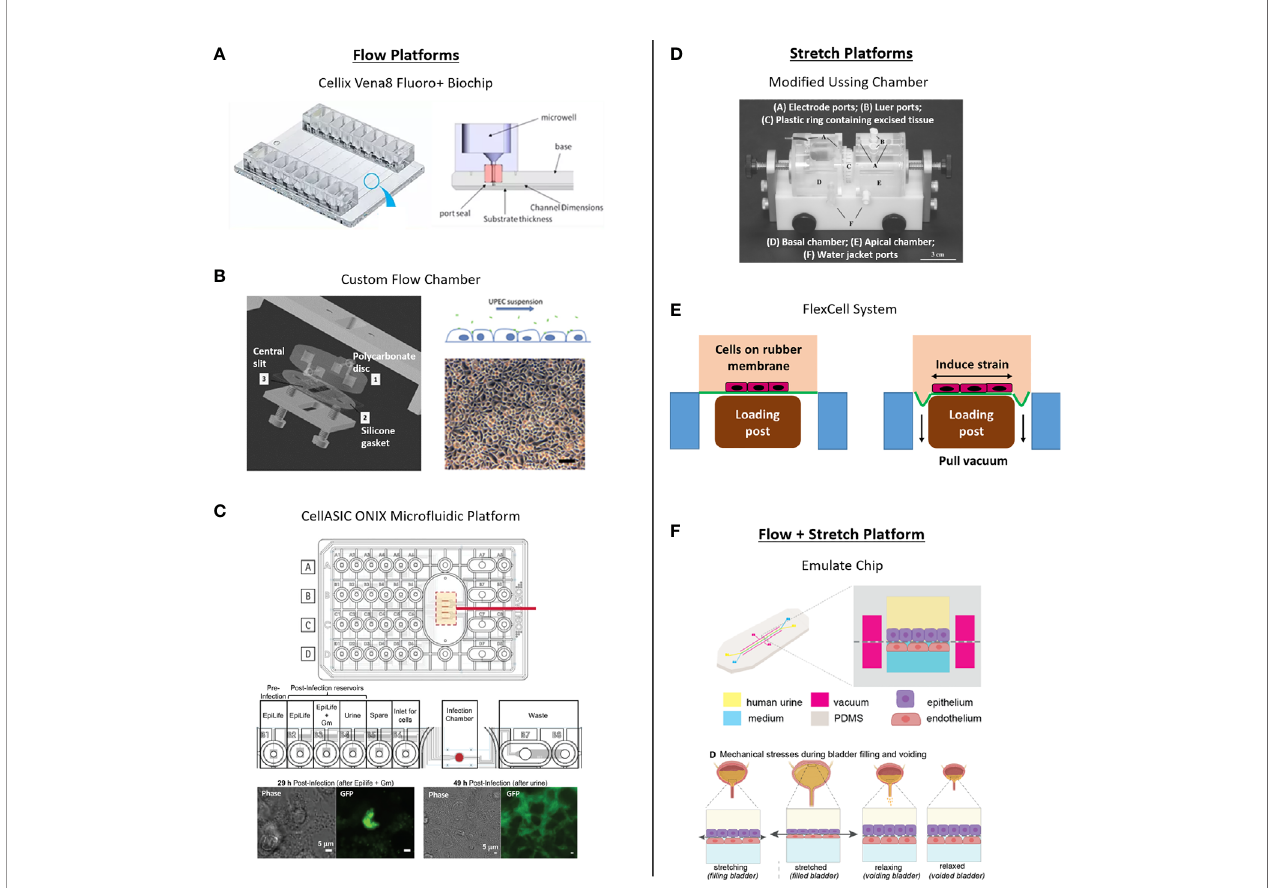
FIGURE 2 | Platforms with fl uid fl ow and/or mechanical stretch used for in vitro bladder studies. (A) The Cellix Vena8 Fluoro+ Biochip was used by Feenstra et al., 2017 to study E. coli adhesion to human microvascular endothelial cells and bladder epithelial cell lines. Figures modi fi ed from Cellix company website, with permission. (B) Custom fl ow chambers were used by Andersen et al., 2012 and Zalewska-Piatek et al., 2020 to study the role of fl ow in E. coli adhesion to human bladder epithelial cells. Example shown is from Andersen et al., 2012 reproduced with permission from the American Society for Microbiology. (C) The CellASIC ONIX platform was used by Iosi fi dis and Duggin, 2020 to study the role of urine composition and pH on UPEC infection of a bladder epithelial cell line. Top schematic of plate from Lee et al., reproduced with permission from Springer Nature. Bottom panel from Iosi fi dis and Duggin, 2020 reproduced with permission from the American Society for Microbiology. (D) Truschel et al., 2002 used modi fi ed Ussing chambers to induce stretch of excised rabbit bladder tissue. Figure reproduced in compliance with the Creative Commons Non-Commercial Share Alike 3.0 Uported license agreement. (E) FlexCell systems were used by Sun et al., 2001 and 2004 studies to investigate ATP release from primary human bladder urothelial cells from healthy and IC patients. Author schematic depicting the platform ’ s function. (F) Recently, Sharma et al., 2021 used Emulate ’ s organ-on-chip platform that incorporates both fl uid fl ow and stretch in a bladder chip model of infection. Figure modi fi ed from Sharma et al., 2021 pre-print in compliance with the Creative Commons CC-BY-NC-ND 4.0 International